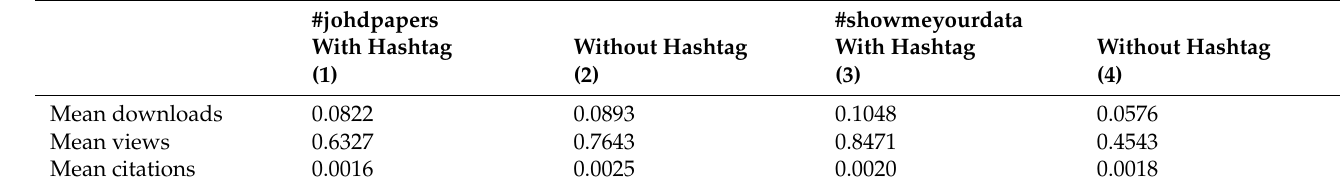
Table 10. Means of the number of downloads, views and citations for the papers which had an associated tweet with the hashtag #johdpapers (first column) and without the hashtag #johdpapers (second column), and for the papers with an associated tweet with (third column) and without (fourth column) the hashtag #showmeyourdata.